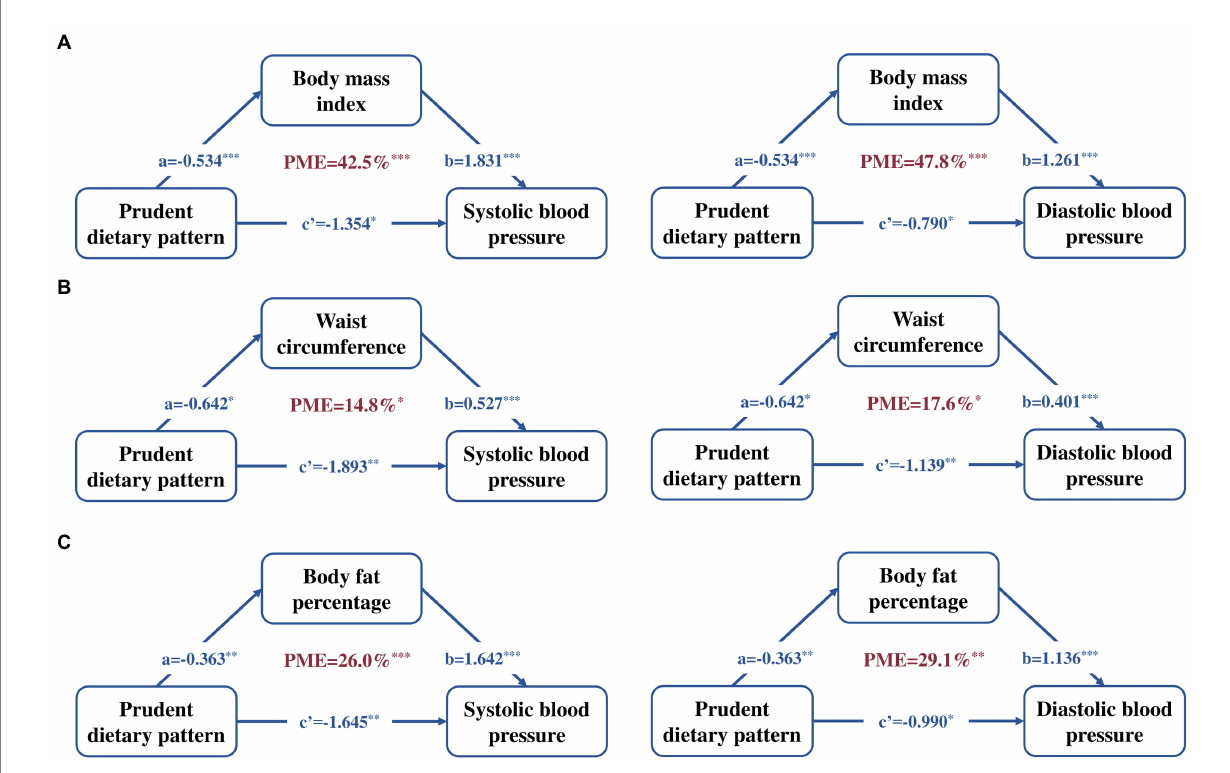
FIGURE 2 Mediation linkages among the prudent patterns scores (continuous exposure), blood pressure (continuous outcome) and body composition (continuous mediator). Adjusted for age, gender, alcohol consumption, current smoker, energy intake and physical activity. (A) BMI as the independent variable, (B) WC as the independent variable, and (C) BF% as the independent variable. Regression coefficients are presented, with the path a representing the effect of prudent patterns scores on body composition, path b representing the effect of body composition on blood pressure, path c’ representing the direct effect of prudent patterns scores on blood pressure, The PME reflects the proportion of the total effect of the prudent patterns scores on the blood pressure that is explained by body composition. * p < 0.05, ** p < 0.01, *** p < 0.001. BMI, body mass index; DBP, diastolic blood pressure; PME, the proportion of mediated effect; SBP, systolic blood pressure; WC, waist circumstance; BF%, body fat